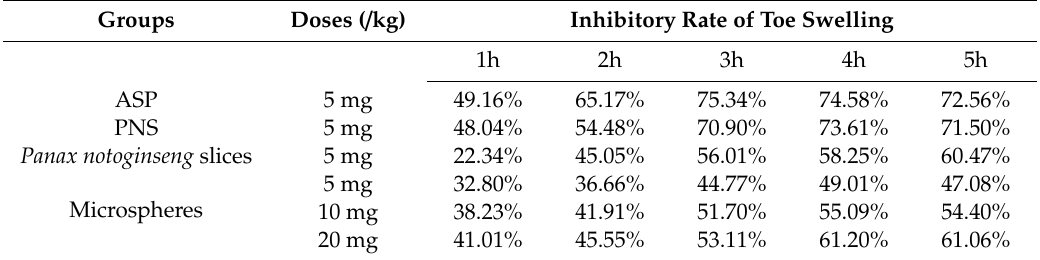
Table 4. Anti-inflammatory activity of PNS microspheres on toe swelling induced by egg white in rats.